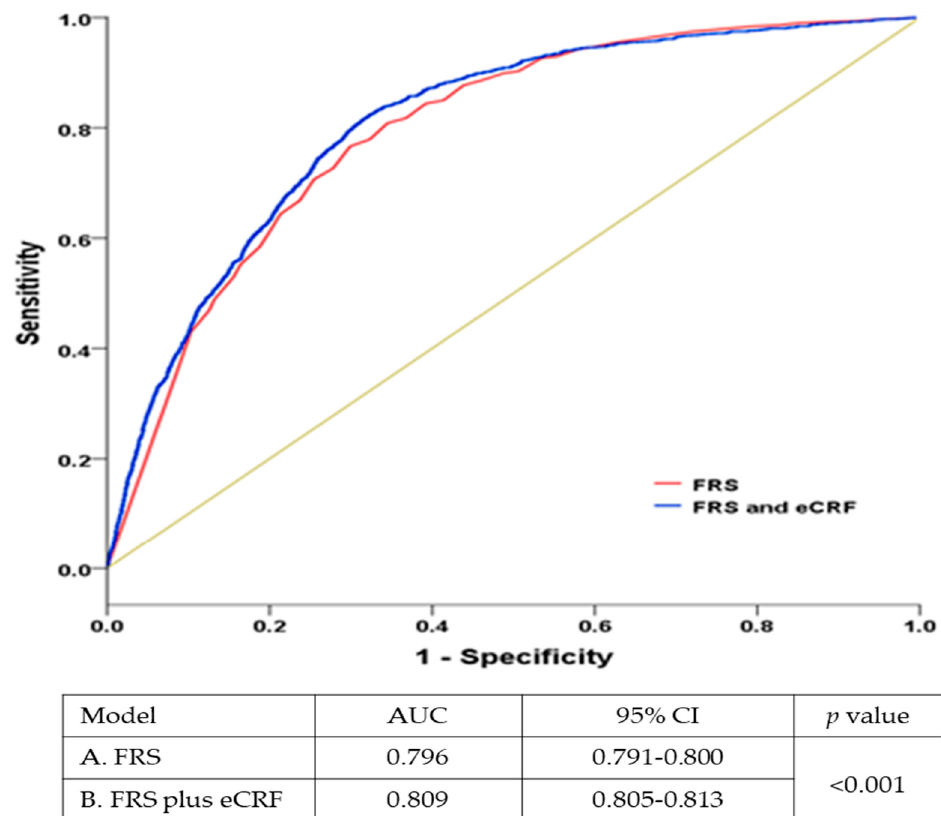
Figure 3. Receiver operating characteristic curve (AUC) comparing the predictive ability of the Framingham risk score (FRS) (Model A) compared to the FRS plus estimated cardiorespiratory fitness (eCRF) (Model B).